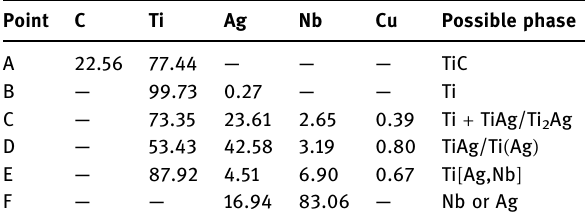
Table 1: Results of EDS at di ff erent positions shown in Figure 2 ( at% ) Point